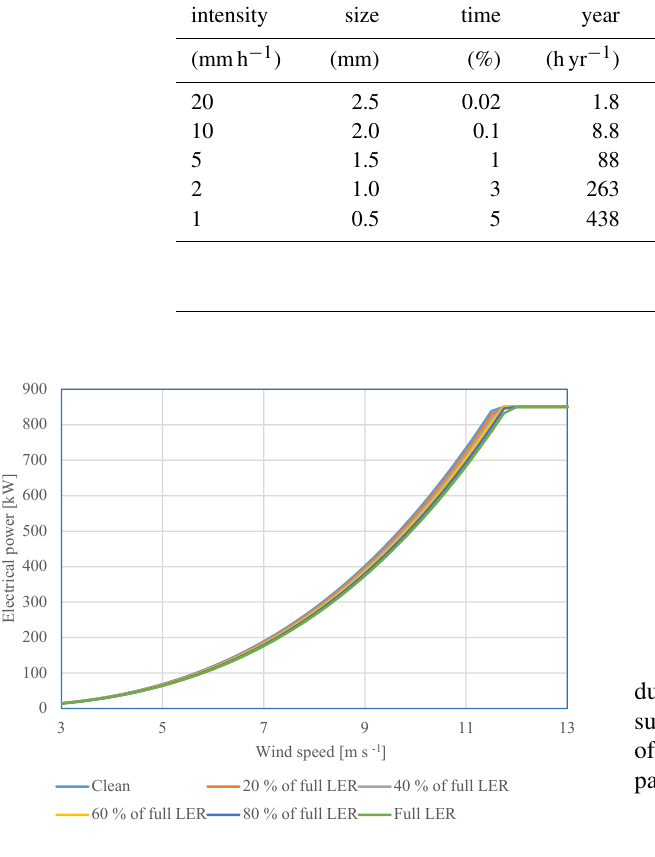
Figure 14. Simulated power curves for the Vestas V52 for different leading-edge roughness levels.